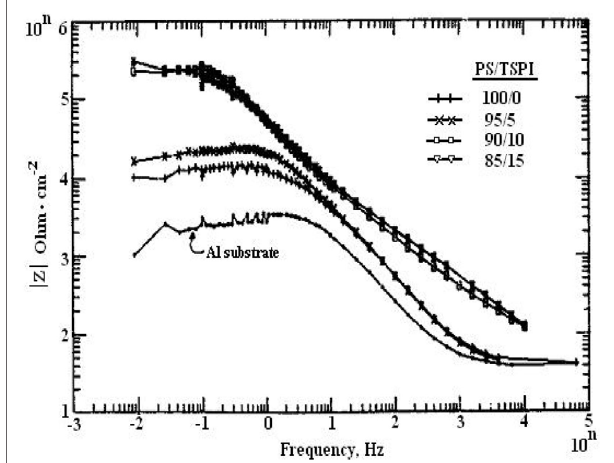
FiGURe 2 | Bode magnitude plots for a bare Al substrates and Al specimens coated with films with 100/0, 95/5, 90/10, and 85/15 ratios. Reprinted with permission from Sugama and DuVall (1996). Copyright 1996 Elsevier